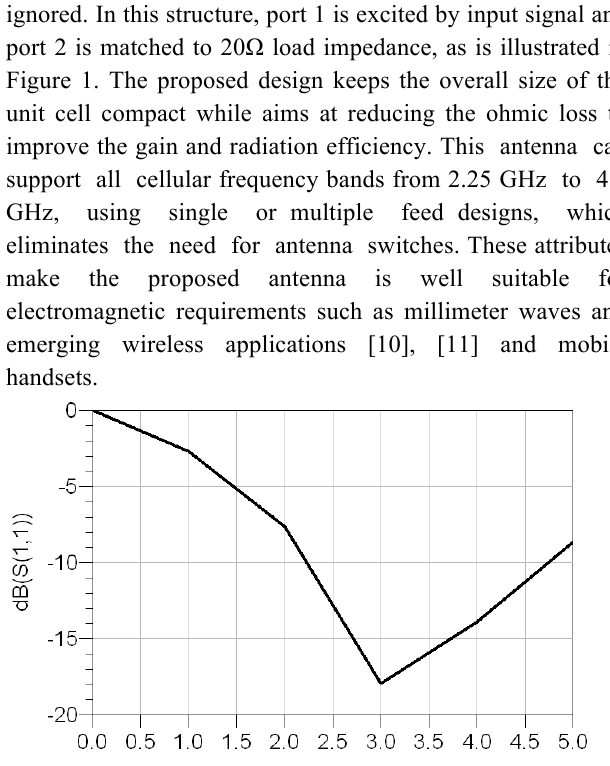
Figure.3. Reflection coefficient, S